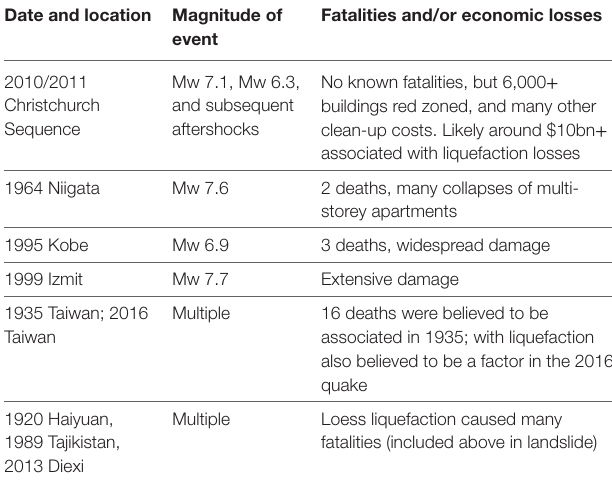
Table 3 | The effect of larger liquefaction events since 1900. Date and location Magnitude of